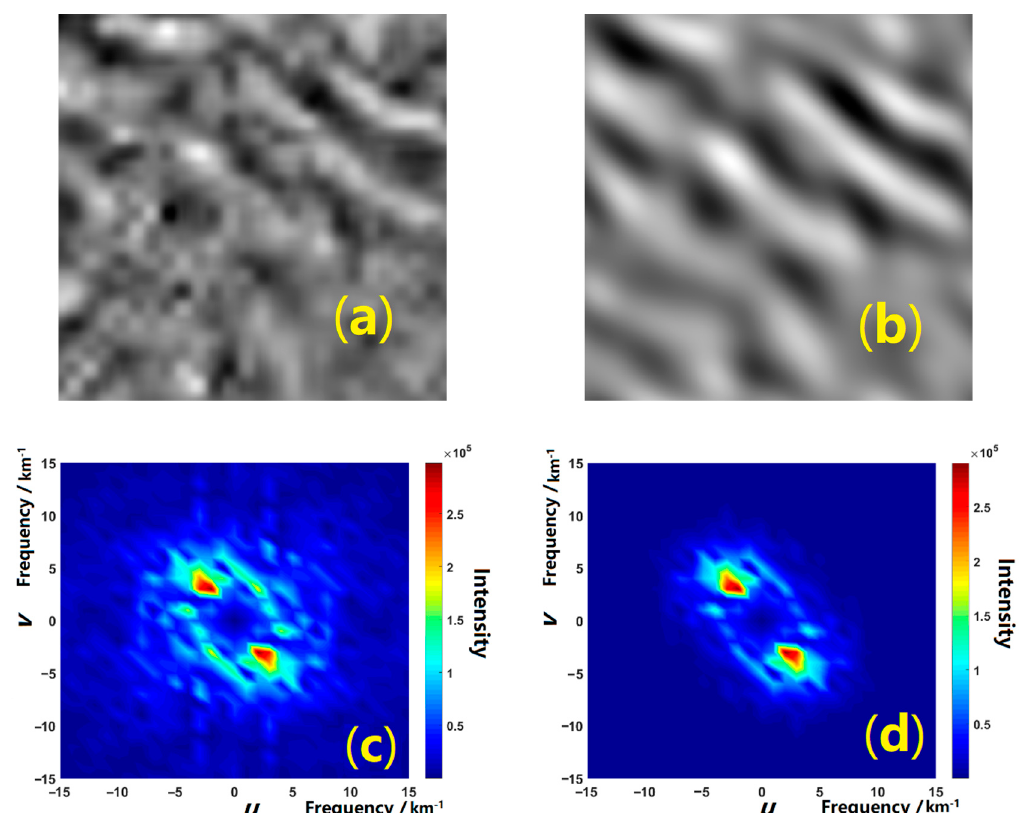
Figure 3. ( a ) Covered region before filtering. ( b ) Covered region after filtering. ( c ) Spectrum before filtering. ( d ) Spectrum after filtering. In ( c ) and ( d ), u and v are the zonal and meridional frequencies, respectively. The color bar indicates the intensity, which is proportional to the grayscale. After filtering, the wave pattern in the image becomes more visible, and the spectrum becomes clearer.